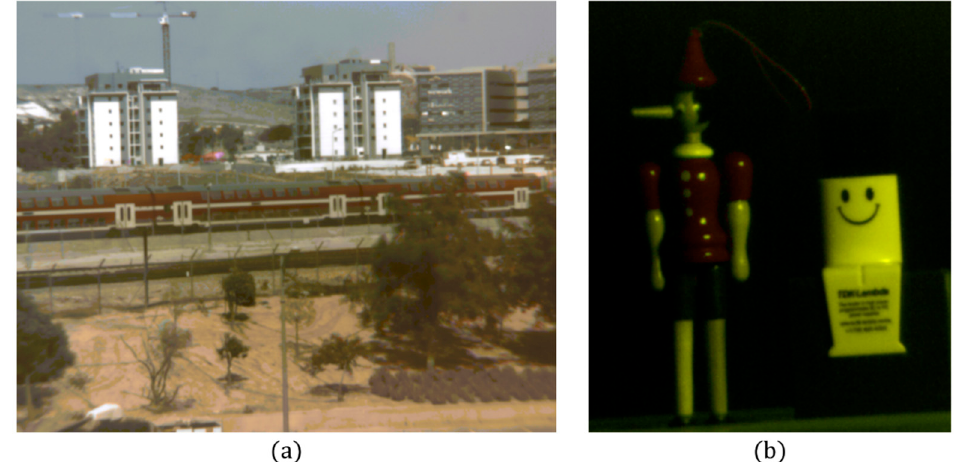
Figure 9. Staring mode reconstruction results with the dictionary of ( a ) outdoor and ( b ) indoor HS images taken with CS-MUSI camera. The figures show RGB representation of the reconstructed HS datacube.